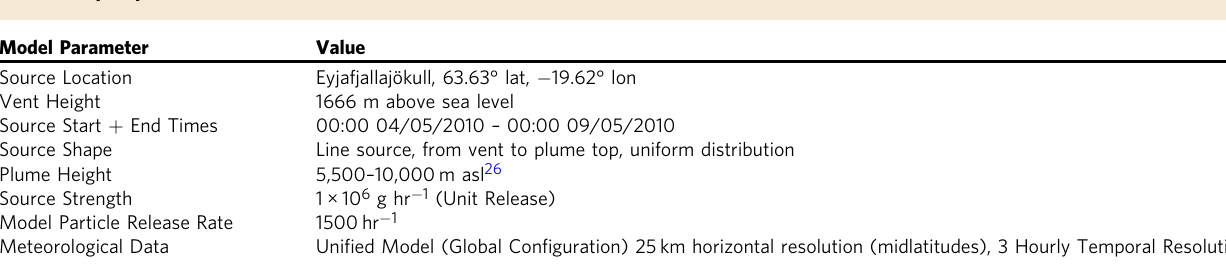
Table 1 Input parameters for the NAME